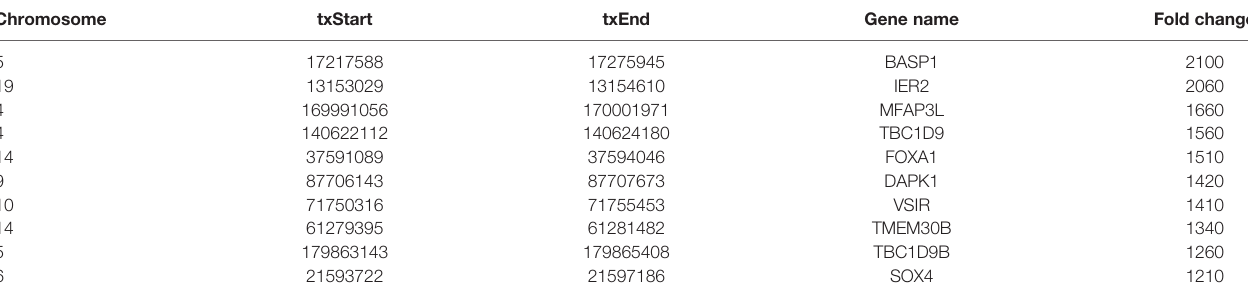
TABLE 1 | The top 10 hypermethylated m6A-modi fi ed peaks for bladder cancer tissues compared to normal tissues. Chromosome